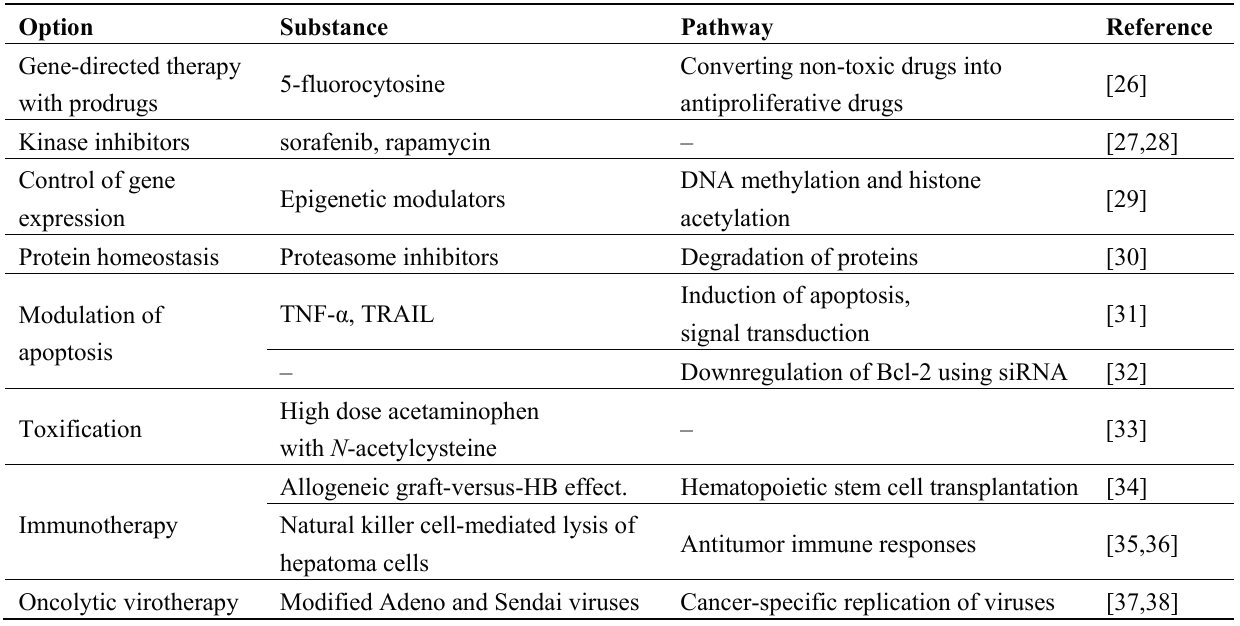
Table 2. Selective alternative treatment proposals for